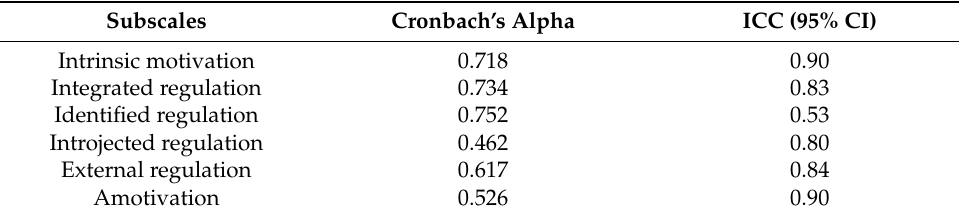
Abbreviations: CI = Confidence Interval, ICC = Intraclass correlation